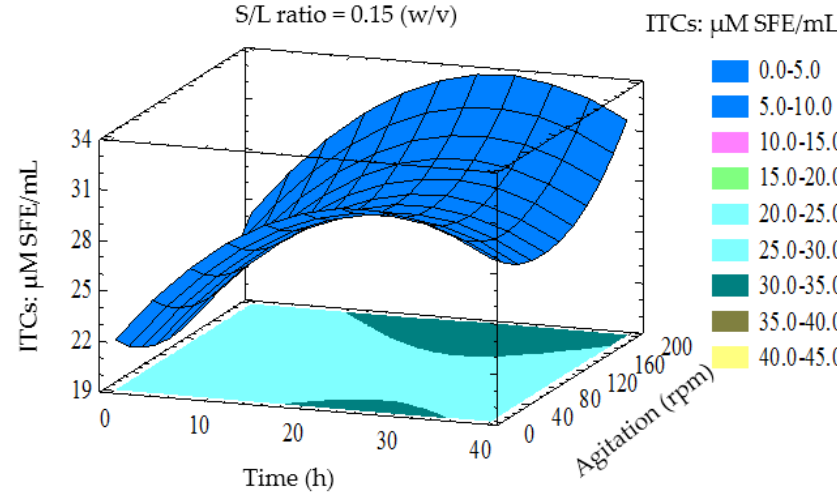
Figure 2. Three-dimensional response surface plot showing the effect of fermentation time (h) and agitation rate on ITCs yield (ITCs: μM SFE/mL) when the response surface is fixed at S/L ratio = 0.15.